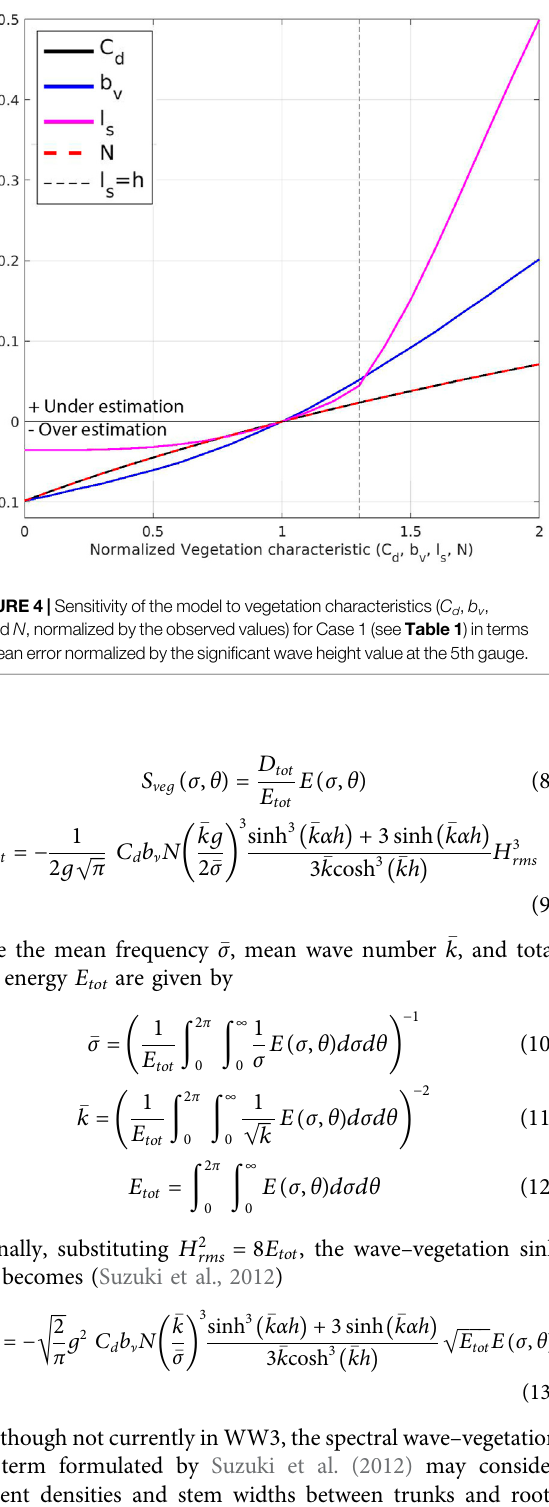
Frontiers in Built Environment |